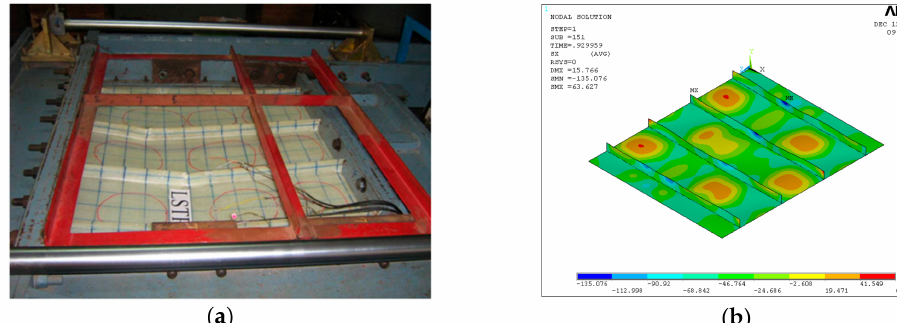
Figure 13. Failure of LSTP1 ( a ) Experiment ( b ) FEA.